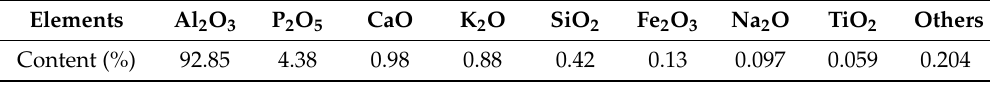
Table 1. The main elements content of spent catalysts analyzed by X-ray fluorescence (XRF).